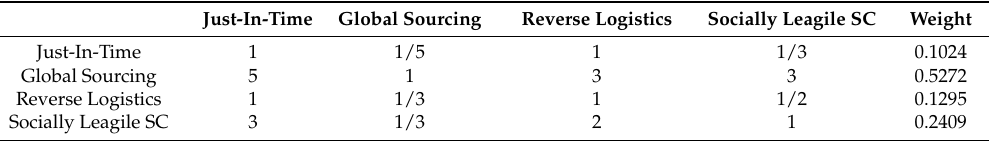
Table A7. Pairwise Comparison of Alternative w.r.t. sub-criterion